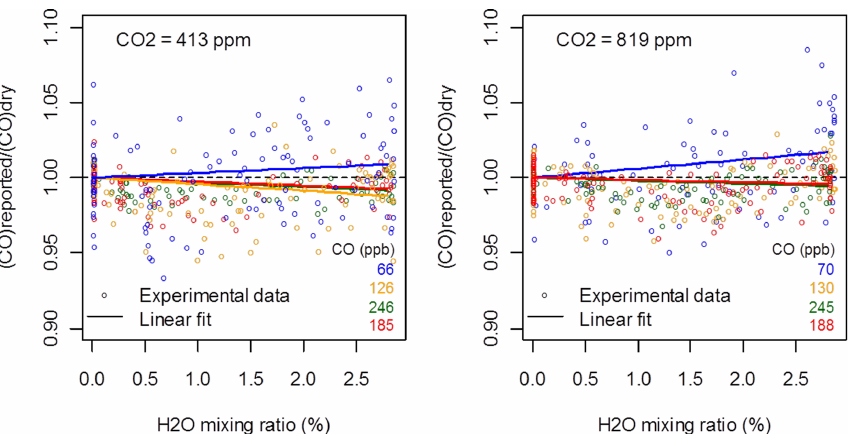
Fig. 12. Ratios of CO reported /CO dry mole fractions vs. the water vapour mixing ratios of a Picarro G2401 CRDS instrument with optimised water vapour correction function for different CO levels. The experiment was done at two different CO 2 mole fractions (left: 413ppm CO 2 , right: 819ppm CO 2